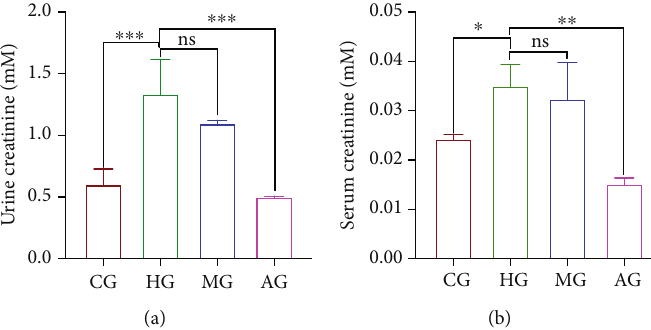
Figure 8: The levels of urine and serum creatinine. (a) The concentration of urine creatinine. (b) The concentration of serum creatinine. n = 3 for each group, and ns P > 0 : 05 , ∗ P < 0 : 05 , ∗∗ P < 0 : 01 , and ∗∗∗ P < 0 : 001 vs. the HG